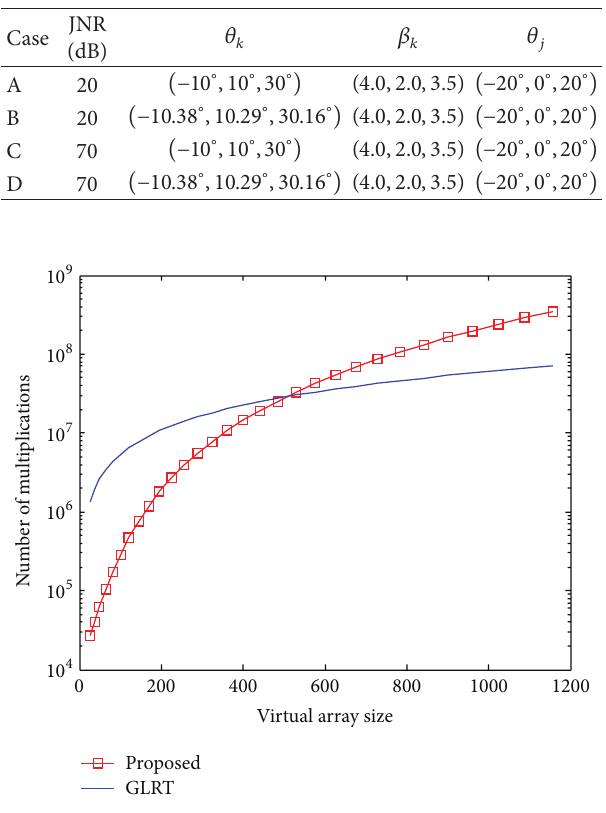
Figure 2: Computational complexity according to the size of the virtual array when 𝑁 = 64 .